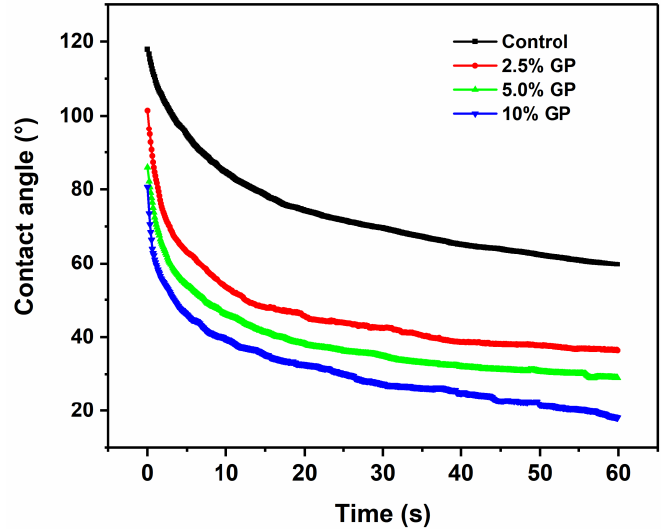
Figure 8. Curves of dynamic contact angle with time in 60 s.